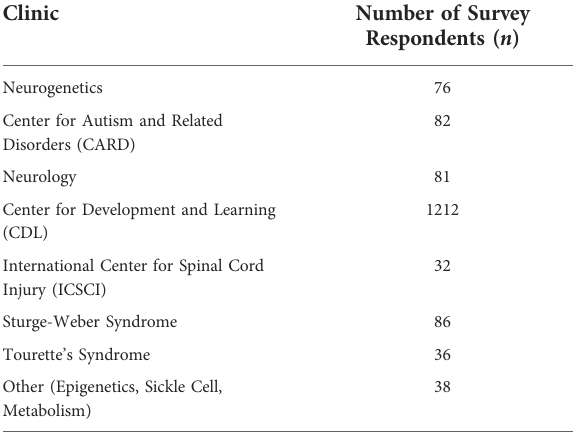
TABLE 1 Clinics and number of survey respondent. TABLE 2 Odds ratios of signi fi cant predictors of pandemic intake